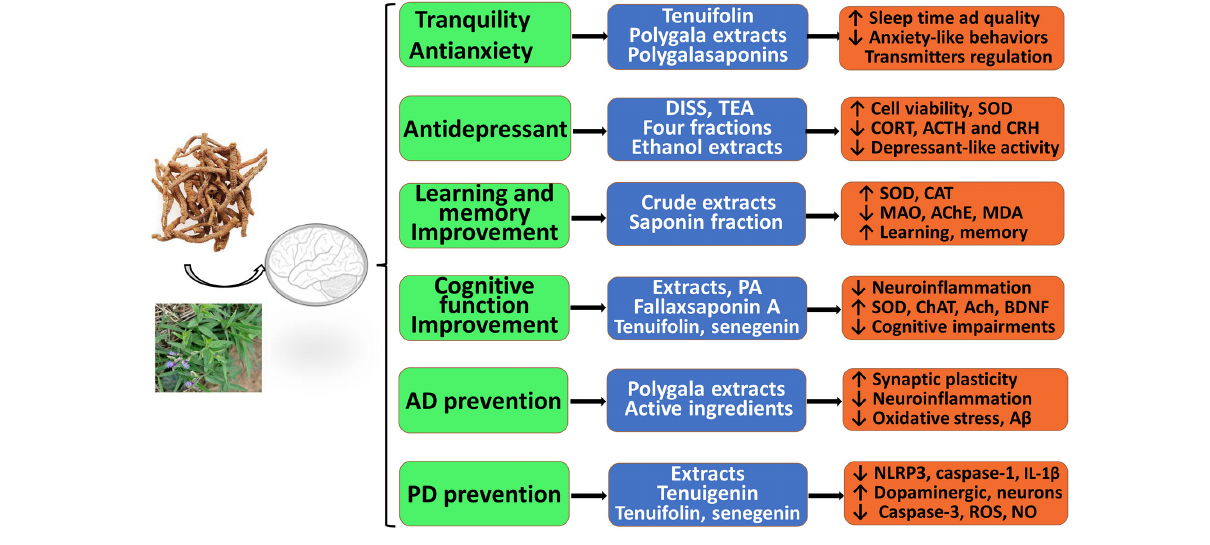
FIGURE 2 | Therapeutic and preventive actions of RP against central nervous system (CNS) neurological and psychotic diseases in vitro and in vivo . It possesses significant pharmacological activities and protective effects with administration of therapeutic material basis, including RP extracts, multiple effective fractions, and single